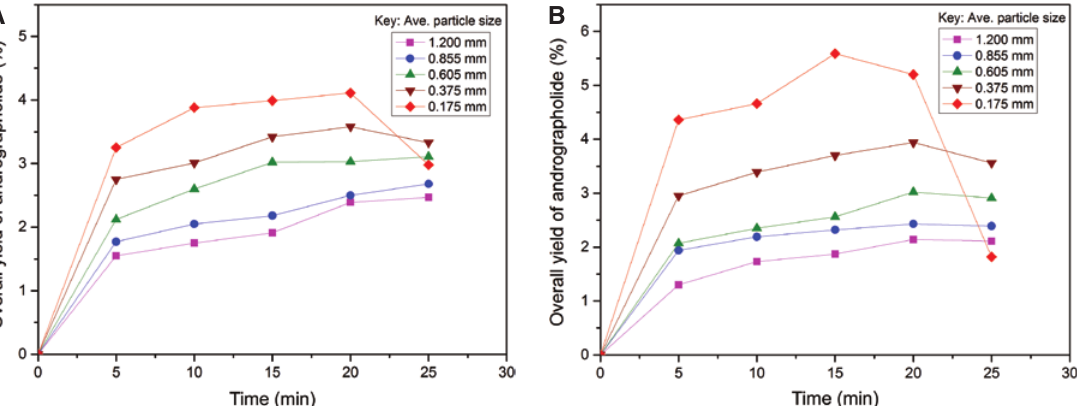
Figure 6: Effect of particle size on the overall yield of andrographolide from Andrographis paniculata (AP) in the green solid-liquid extraction of andrographolide at 80 ° C for solid-liquid ratio of (A) 1:10 (g ml -1 ) and (B) 1:50 (g ml -1 ).